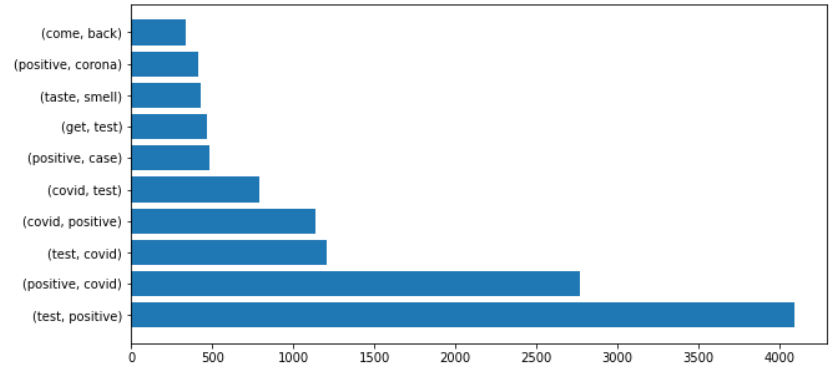
Figure 6. Most frequent bi-grams in the positive class.